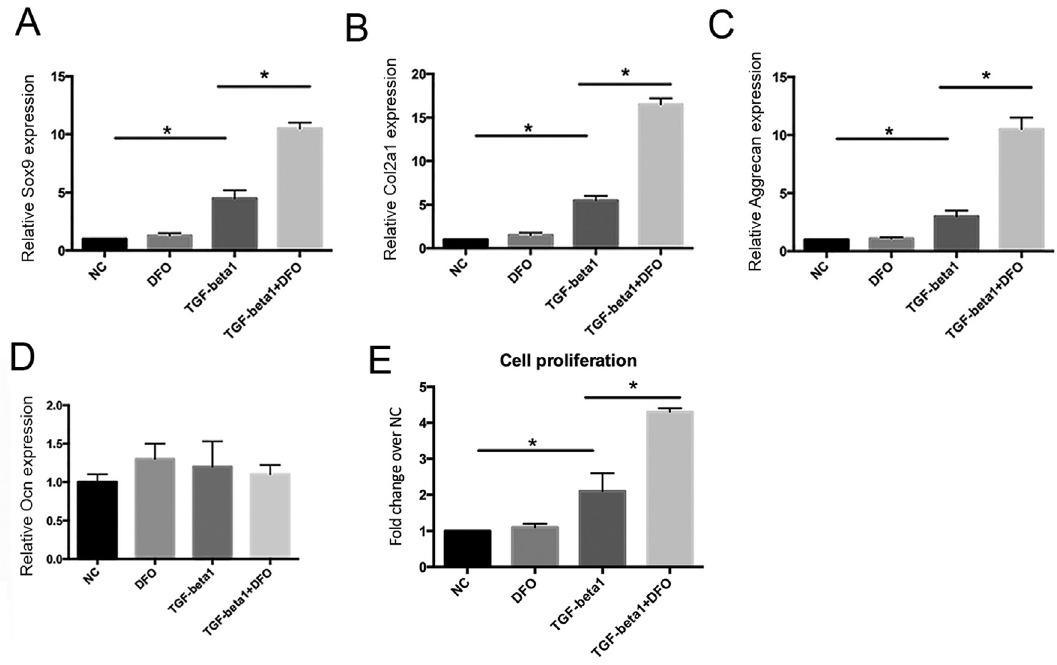
Figure 3 - DFO synergizes with TGF- (cid:15) 1 in chondrogenesis and proliferation in primary chondrocytes. (A-D) Primary chondrocytes were treated with DFO, TGF- (cid:15) 1 or both for three days, after which Sox9 (A), Col2a1 (B), aggrecan (C) and Ocn (D) gene expression was assessed. (E) Primary chondrocytesweretreatedwithDFO,TGF- (cid:15) 1orbothforthreedays,afterwhichcellproliferationwasdeterminedbytheAlamarBlue ® assay.Theresults are expressed as the fold-change in proliferation relative to non-treated control cells (NC). The columns represent the mean + 1 SD (n = 3 each). *p < 0.05 for cells treated with TGF- (cid:15) 1 vs. NC cells and for cells treated with TGF- (cid:15) 1 vs. cells treated with TGF- (cid:15) 1 + DFO.